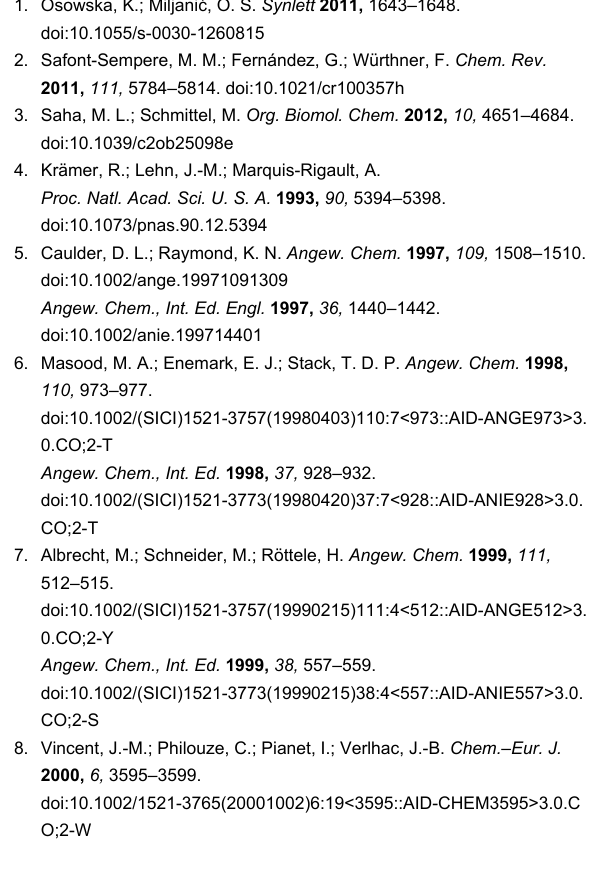
Crystal structure determination: Data for the X-ray crystallo- graphic analysis of [(dppp) 2 Pd 2 {( R )- 3 } 2 ][(dppp) 2 Pd 2 {( S )- 3 } 2 ](OTf) 8 derived from ( rac )- 3 and [(dppp)Pd(OTf) 2 ] were collected on a SuperNova Dual Source diffractometer equipped with an Atlas detector using mirror monochromated Mo K a radiation ( λ = 0.71073 Å). CrysAlisPro software [39] was used for data measurement and processing as well as to apply the numerical absorption correction. The structures were solved by direct methods (SIR97 [40]) and refined by full-matrix least squares on F 2 (SHELXL-2013 [41]). All non-hydrogen atoms were refined anisotropically. The SQUEEZE routine of PLATON [42] was used to calculate the contributions of the disordered solvent regions to the structure factors in the form of FAB files which were then used in refinement in SHELXL- 2013. The hydrogen atoms at carbon were placed in calculated positions and refined isotropically using a riding